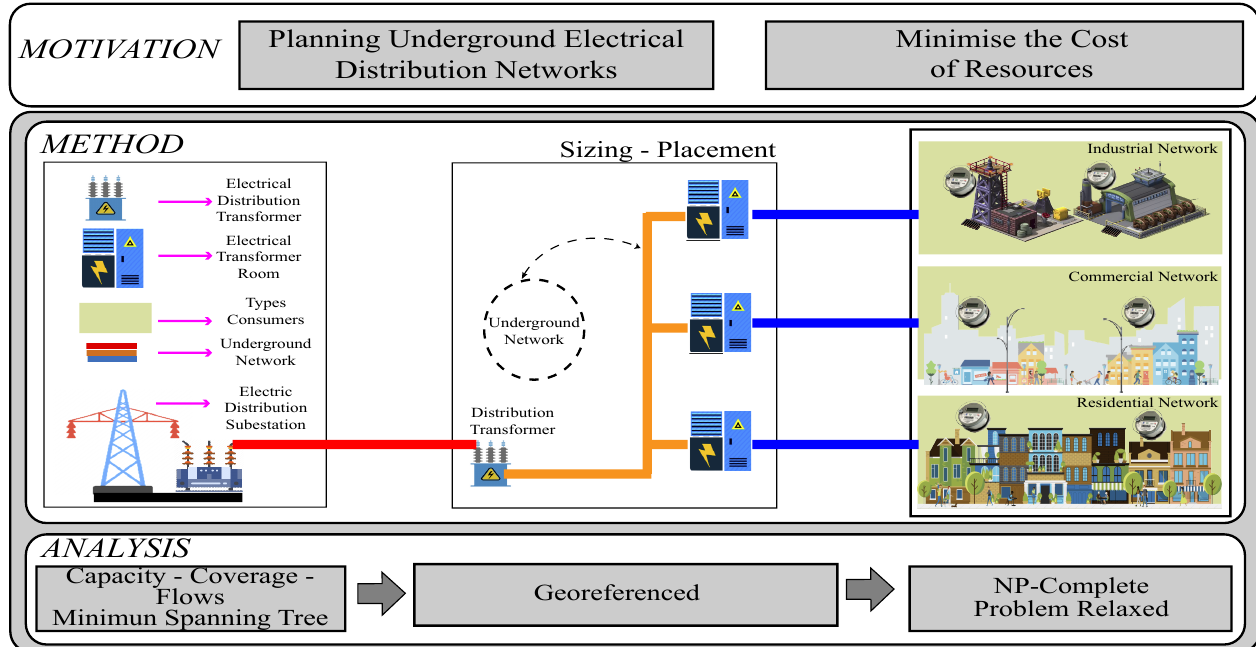
Figure 1. Underground electrical distribution